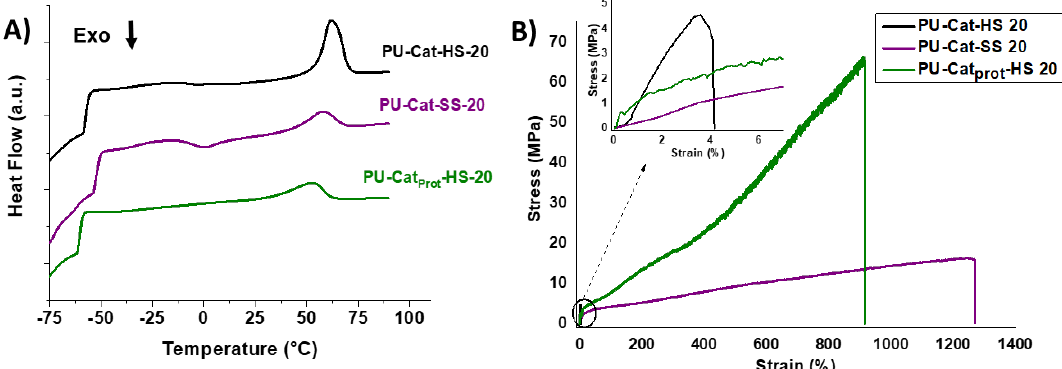
Figure 7. ( A ) DSC measurements of polyurethanes functionalized with free (in HS and SS) and protected catechol. ( B ) Comparison between stress–strain curves for the three synthetized polyurethanes.